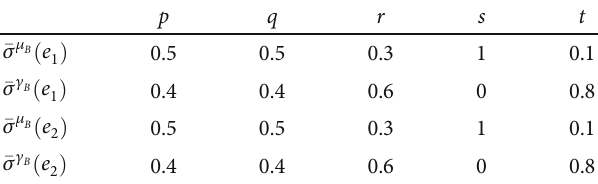
Table 11: Upper approximation of B .